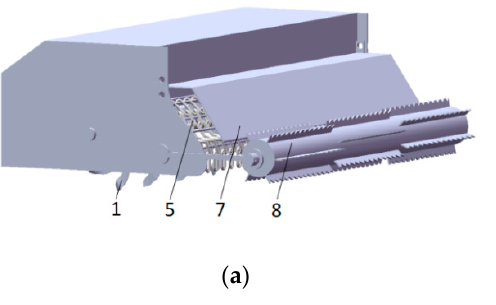
Figure 1. Separated burying device. 1. Rotary tillage blade 2. Rotary blade holder 3. Rotary blade axis 4. Stem model 5. The chain 6. Soil particle model 7. Soil retaining plate 8. To suppress wheel 9. Soil model. ( a ) Schematic diagram of separation and burial device. ( b ) Schematic diagram of principle of “separation and burial Device”.